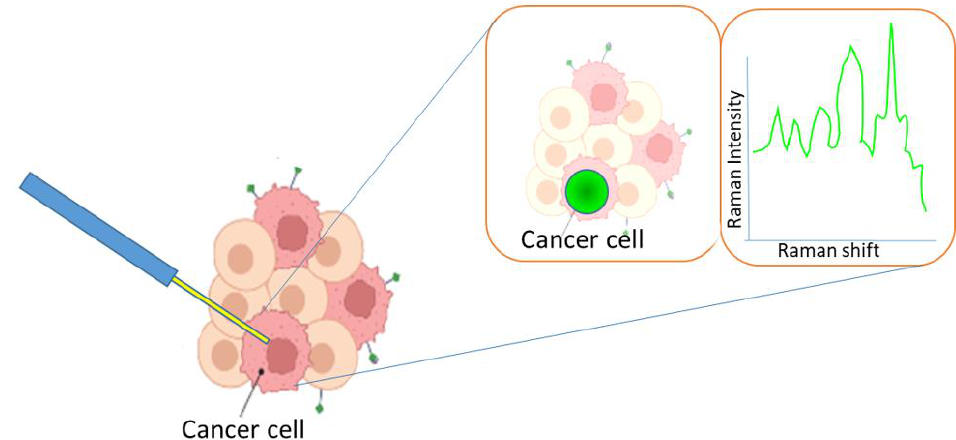
Figure 3. Application of Raman technique in cancer diagnosis.